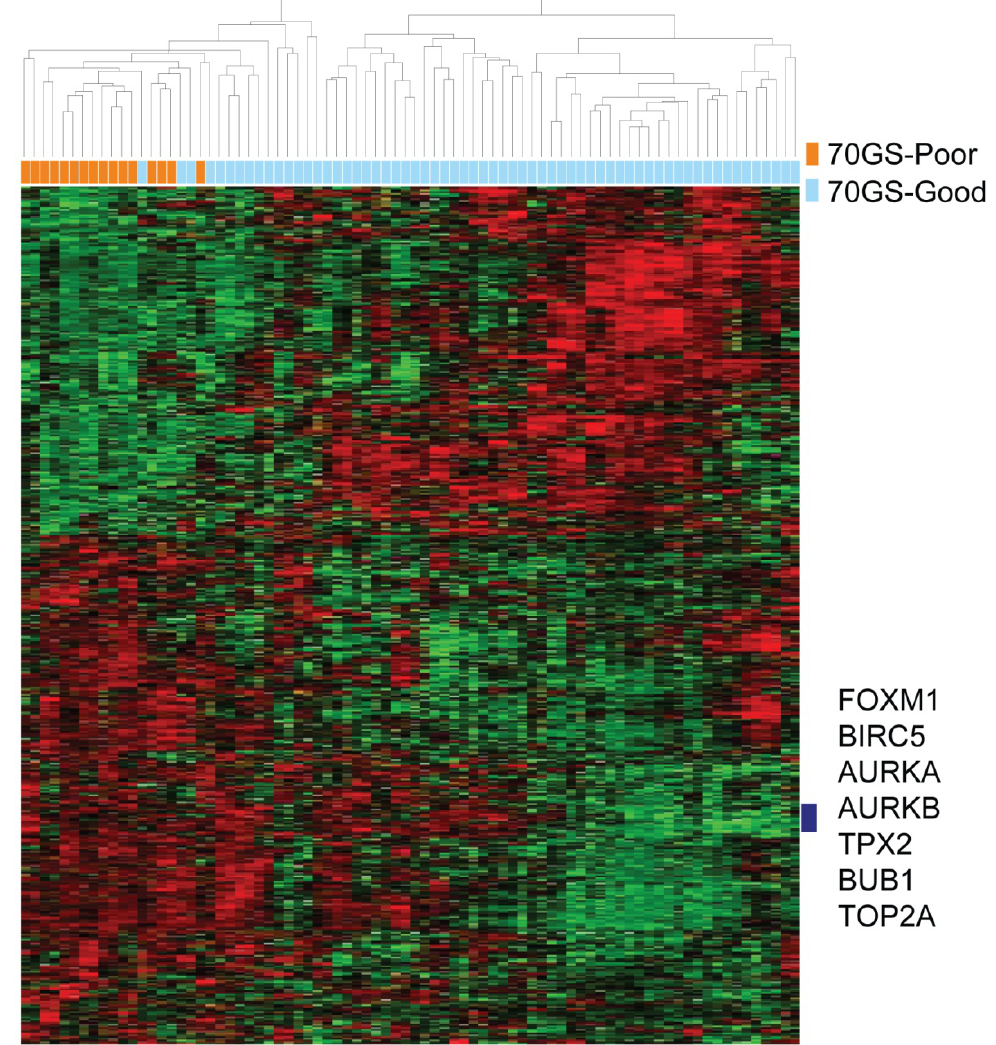
Figure 3. Hierarchical clustering analysis of 487 gene features according to 70GS among patients with ER-positive breast cancer and intermediate risk scores. Columns represent individual samples, and rows represent individual genes. Red and green reflect high and low expression levels (log2-transformed scale), respectively.